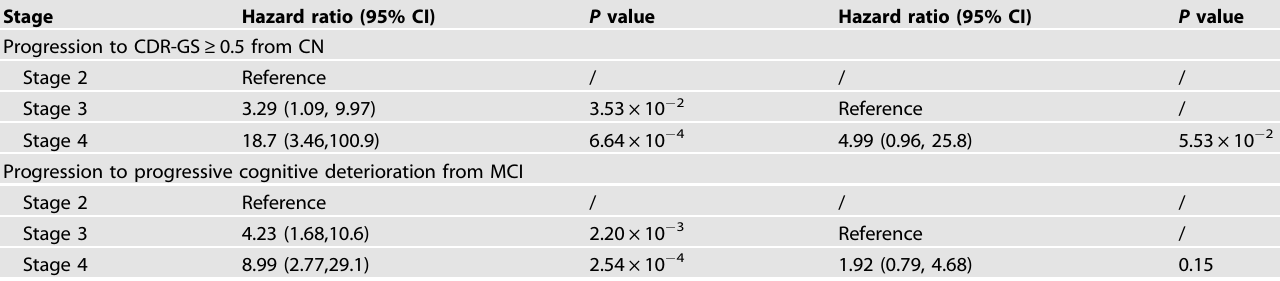
Table 2. Progression risk from CN and